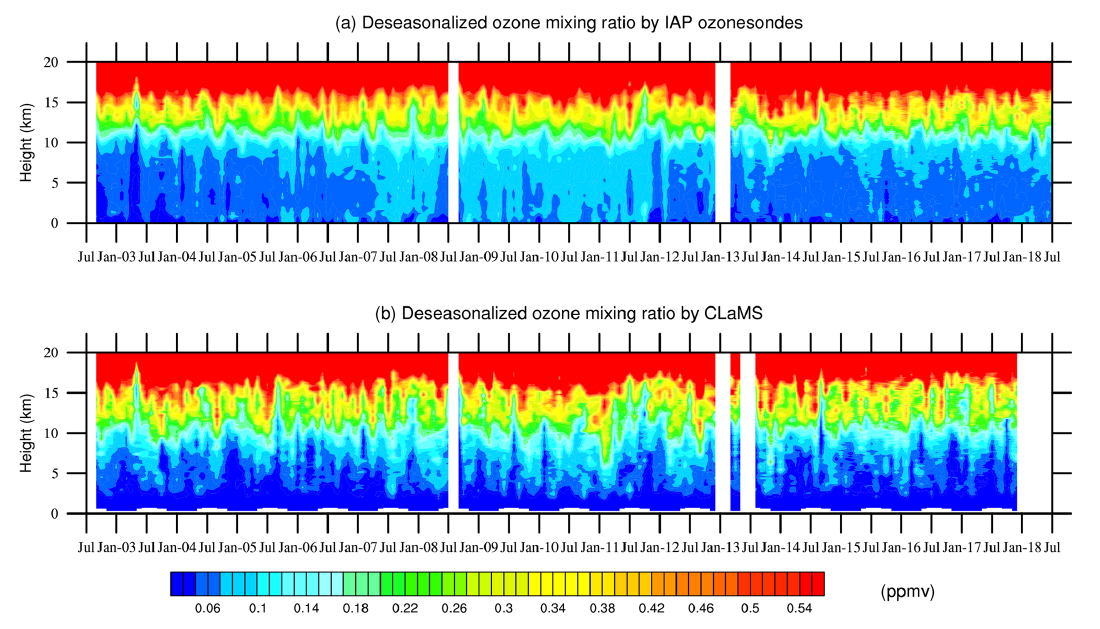
Figure 1. Deseasonalized monthly mean ozone mixing ratio (units: ppmv) over Beijing (a) measured by the IAP ozonesonde and (b) simu- lated by CLaMS. There was no ozonesonde observation in July 2008 and January 2013. CLaMS is unable to calculate the ozone mixing ratio in July 2013 because the information of balloon locations was lost during this